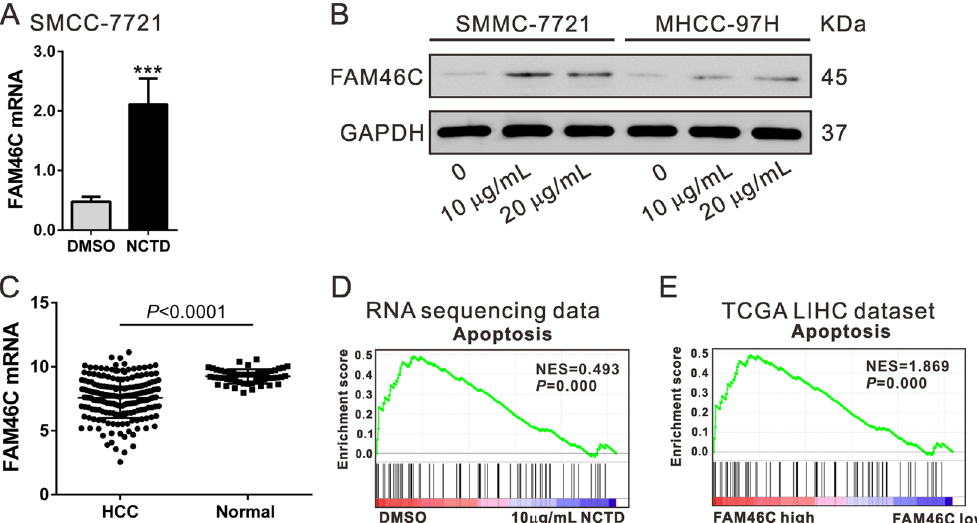
Figure 2. Effects of NCTD on FAM46C expression. ( A ) RNA-sequencing data showed that NCTD significantly induced FAM46C mRNA expression. ( B ) SMCC-7721 and MHCC-97H cells were treated with DMSO or NCTD (10 and 20 µ g/mL) for 48 h. The protein level of FAM46C was significantly induced by NCTD treatment. ( C ) FAM46C was down-regulated in HCC tissues (n = 191) compared to the normal tissues (n = 50) in TCGA LIHC dataset. ( D ) GSEA revealed that the cell apoptosis pathway was closely related with NCTD treatment. Black bars indicated individual genes in rank order. NES, normalized enrichment score. ( E ) GSEA was performed using TCGA LIHC dataset. The cell apoptosis pathway was strongly associated with FAM46C